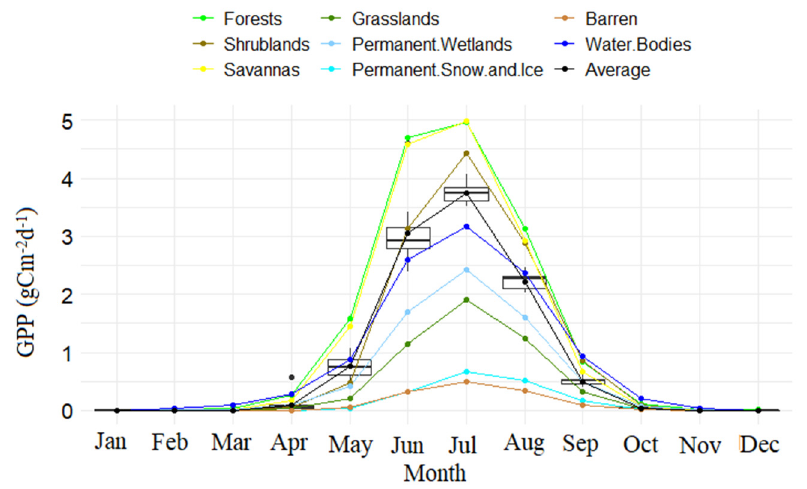
Figure 13. Multiyear averaged monthly GPP distribution over the entire study period for different land cover types (denoted by colored lines) over the Arctic. The black boxplots denote the multiyear monthly GPP distribution of all land cover types.